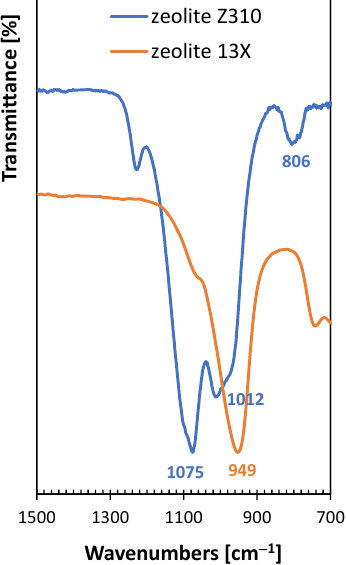
Figure 3. SEM images of zeolite 13X and Z310.